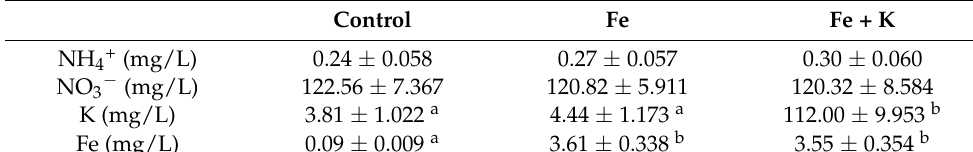
Table 2. Water quality in the cultivation area of the aquaponic systems during the study period (30 days). Data are expressed as mean ± S.E.M. ( n = 15). Means in a row followed by different superscript are significantly different ( p > 0.05).